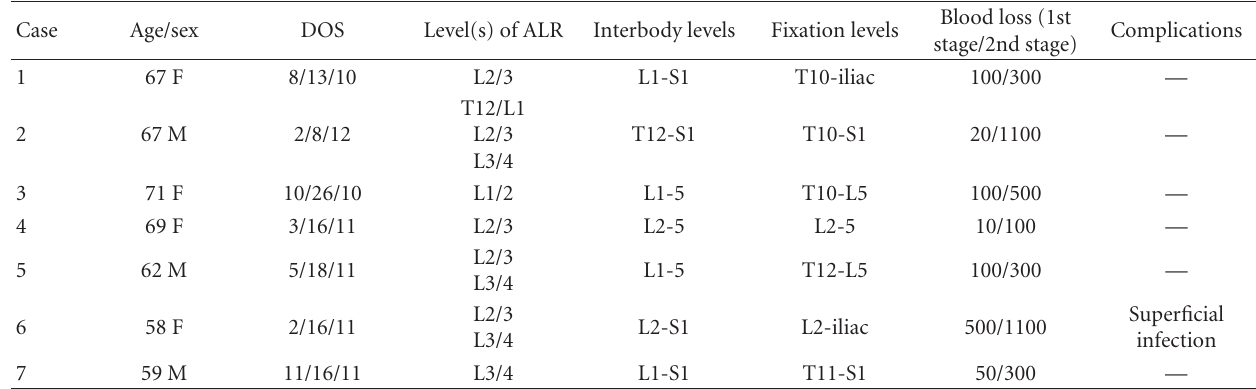
Table 1: Demographic and surgical data of cohort ( n = 7).